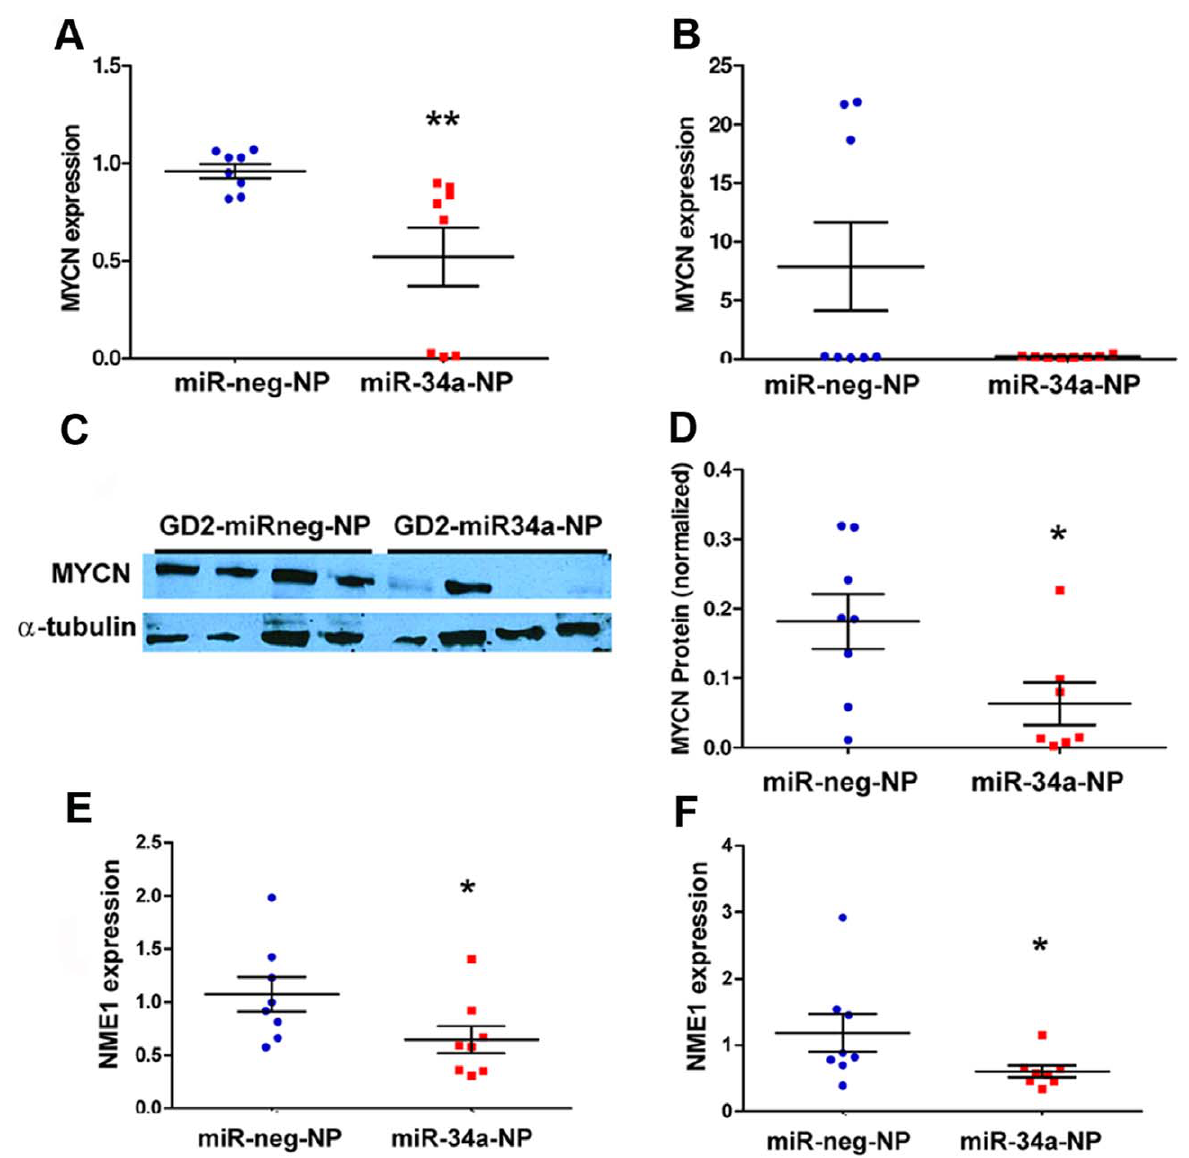
Figure 4. Targeting of MYCN by miR-34a in vivo. (A) MYCN, a validated target of miR-34a, mRNA levels were significantly reduced in GD 2 - miR34a-NP treated NB1691 luc tumors relative to negative controls (**p , 0.001, n=8) (B) qPCR analysis of SK-N-AS luc tumors did not indicate a statistically significant difference between anti-GD 2 -miR34a-NP and anti-GD 2 -miRneg-NP treated tumours, potentially because levels of MYCN expression are very low in this cell line. Three SK-N-AS tumors treated with negative control nanoparticles appeared to have somewhat higher expression then the median, although this level of expression is very low compared to MYCN amplified tumors (C) MYCN reduction in NB1691 luc was validated at a protein level by Western Blot and (D) protein suppression was quantified using densitometry. NME1 , a validated MYCN target, had reduced mRNA levels in anti-GD 2 -miR34a-NP treated NB1691 luc tumors (E) and SK-N-AS luc tumors (F) relative to negative controls (*p , 0.05, n=8), as evaluated by